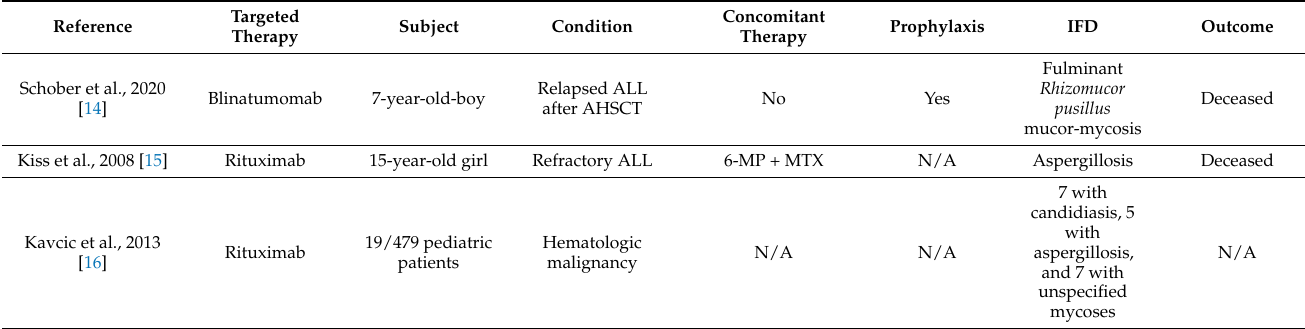
Table 2. Invasive fungal diseases (IFDs) in children with hematological malignancies treated with monoclonal antibodies that target cell surface antigens and immune checkpoint